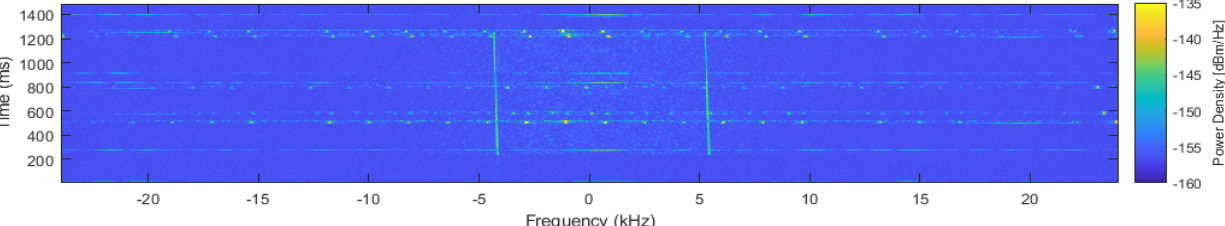
Figure 3. Spectrogram of satellite burst from 0.23 to 1.23 s received at GS close to the